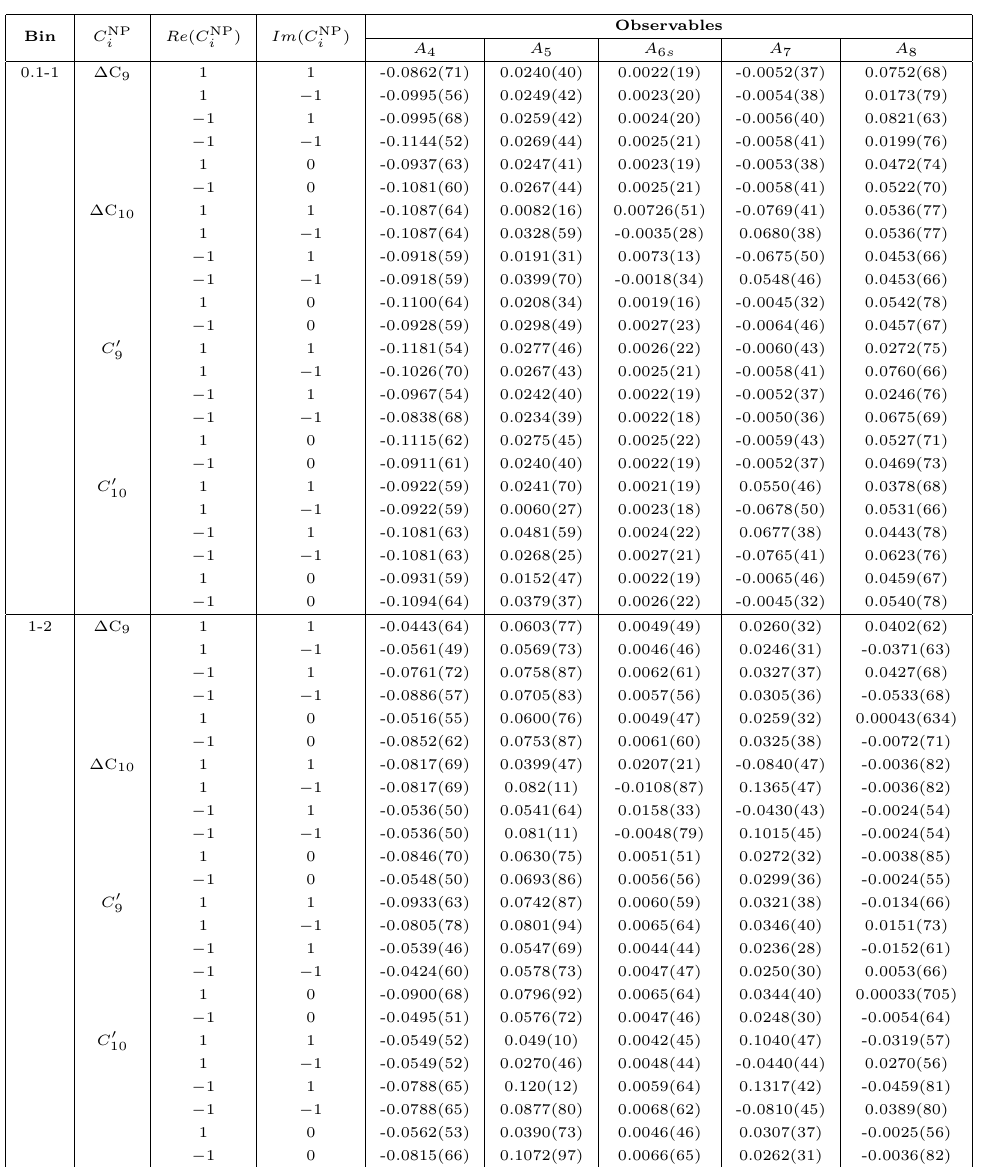
and C 0 for the q 2 bins 0 . 1 − 1 and 1 − 2 GeV 2 for a 9 , 10 9 , 10